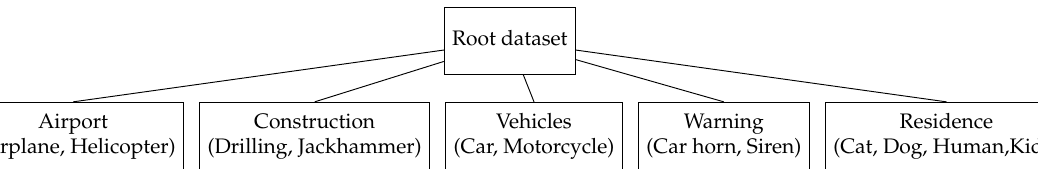
Figure 8. Training dataset for the first stage of the cascade approach. Notice that different sound categories (in brackets) are grouped in the same